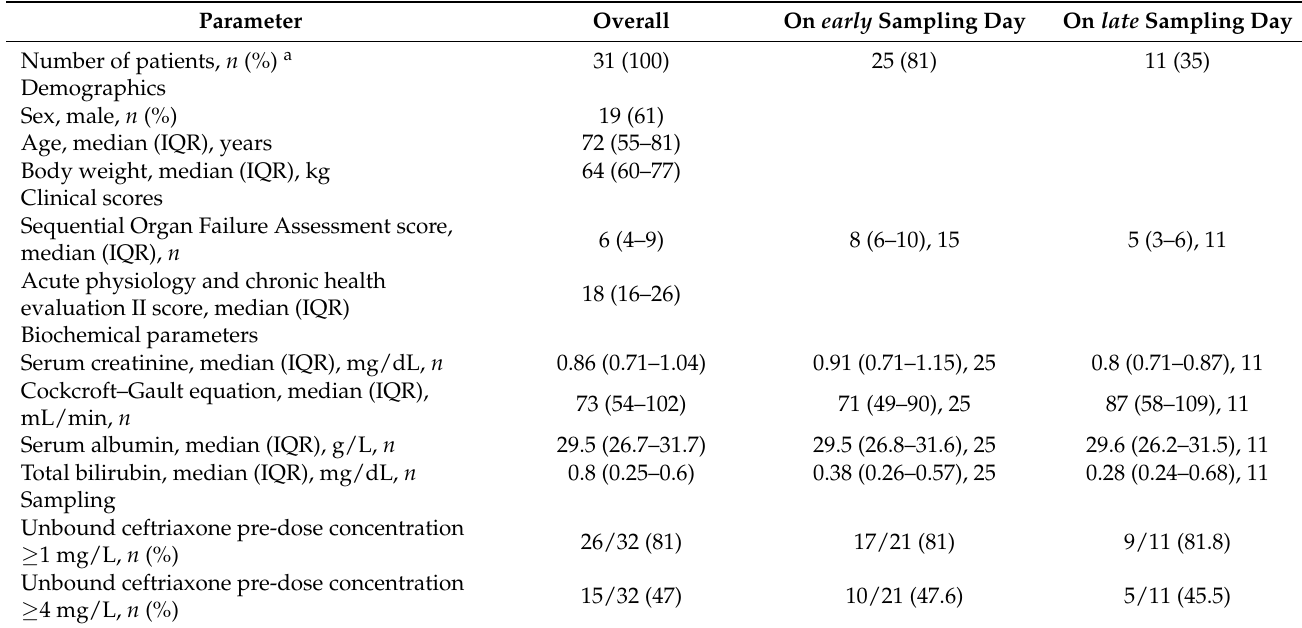
Figure 1. Study flow diagram. Table 1. Patient characteristics.